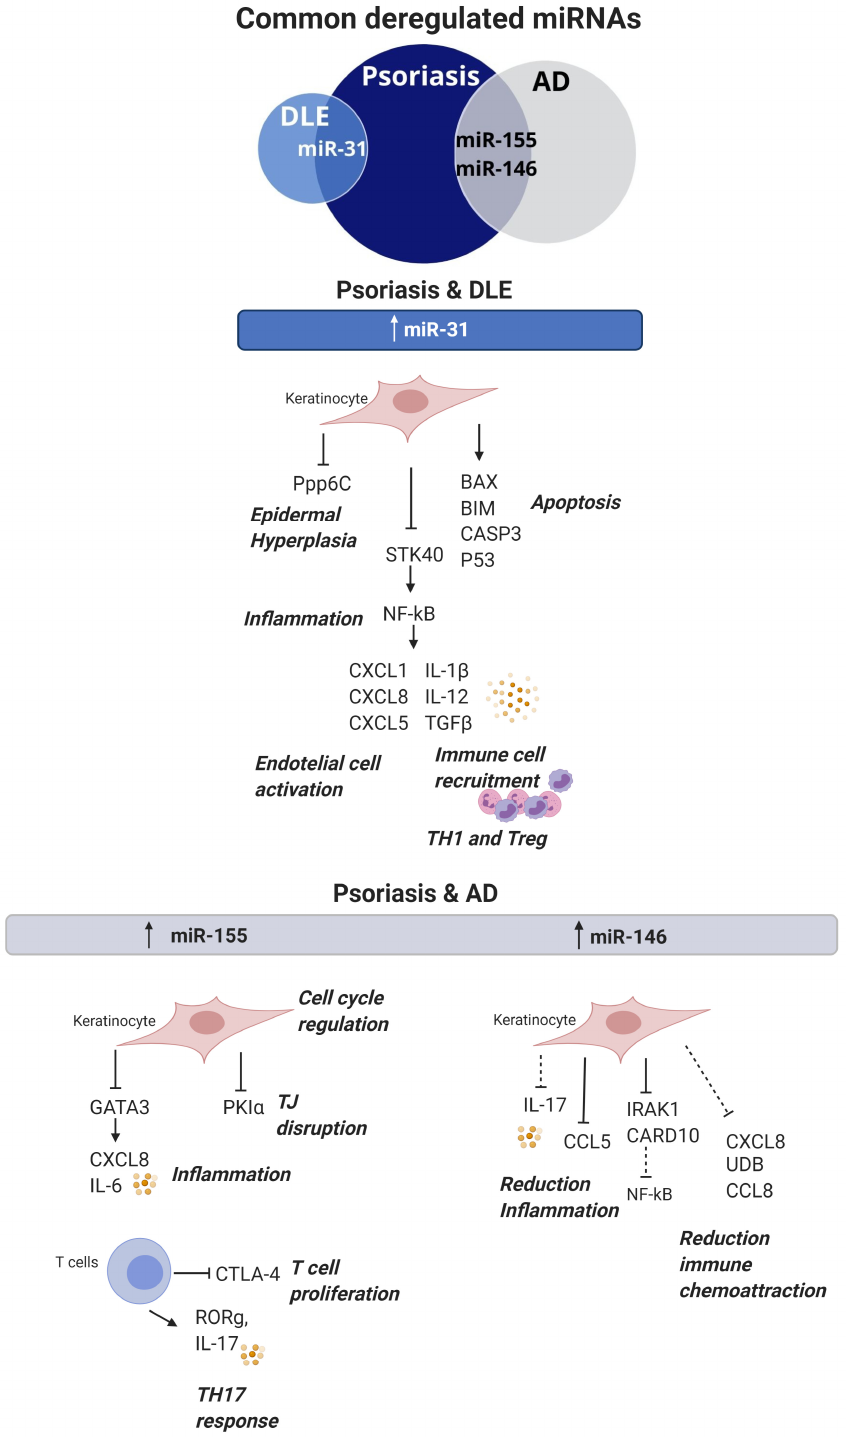
Figure 3. Commonly dysregulated miRNAs and their role in skin autoimmune diseases. MiR-31 is upregulated in both DLE and psoriasis; it participates in keratinocyte proliferation, apoptosis, inflammation and immune cell recruitment. MiR-155 and miR-146 are upregulated in both psoriasis and atopic dermatitis. MiR-155 is involved in keratinocyte proliferation, inflammation and TJ disruption, whereas, in T cells, it promotes proliferation and TH17 responses. MiR-146 has a protective effect and, when upregulated in keratinocytes, promotes a reduction of inflammation and immune chemoattraction. DLE: discoid lupus erythematosus, AD: atopic dermatitis and TJ: tight junction.